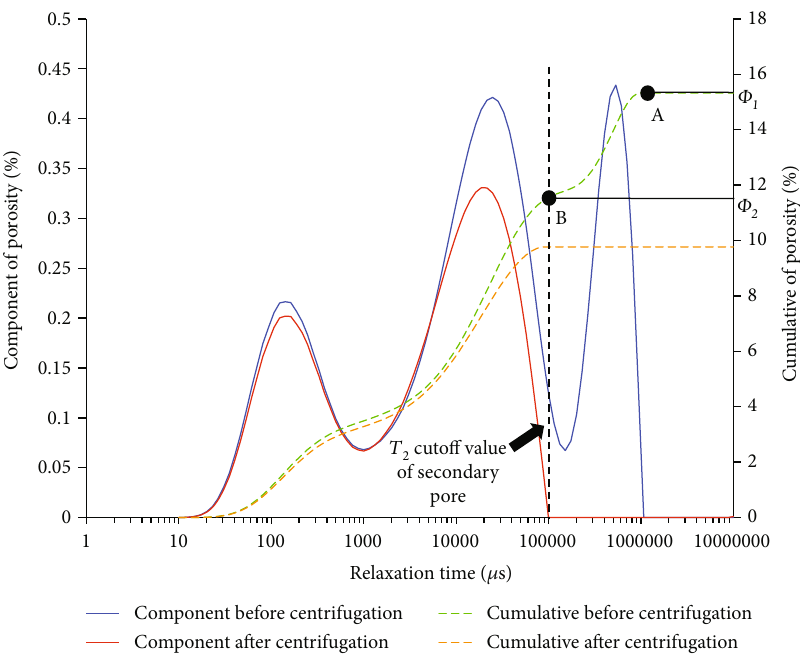
Figure 2: NMR T spectrum of core in well DF51 at 2